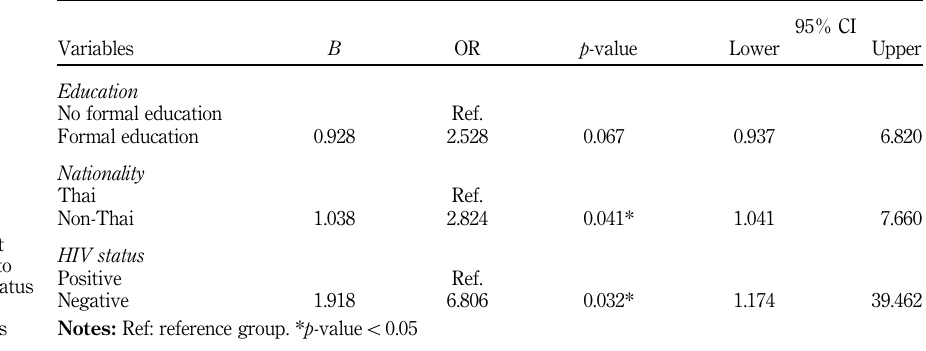
Table IV. Odds ratio and 95% confidence interval of patient delay in relation to education, HIV status and nationality of the TB